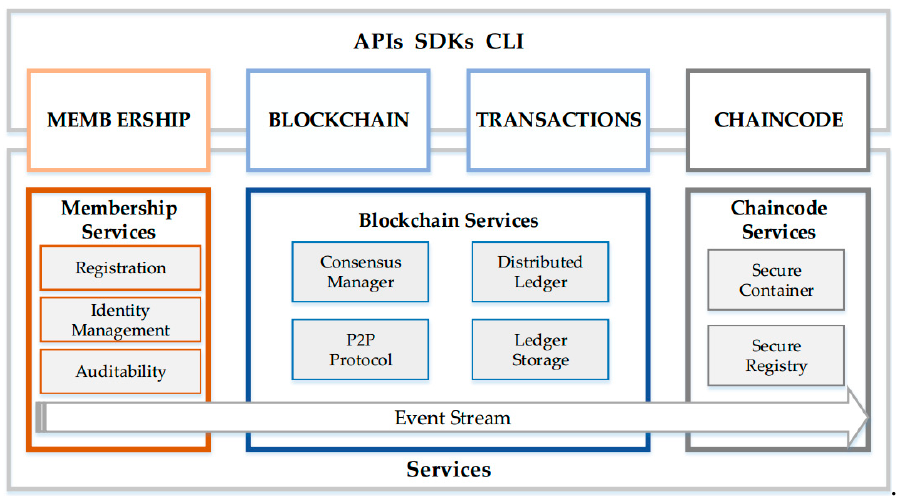
Figure 1. Overall architecture of Fabric.